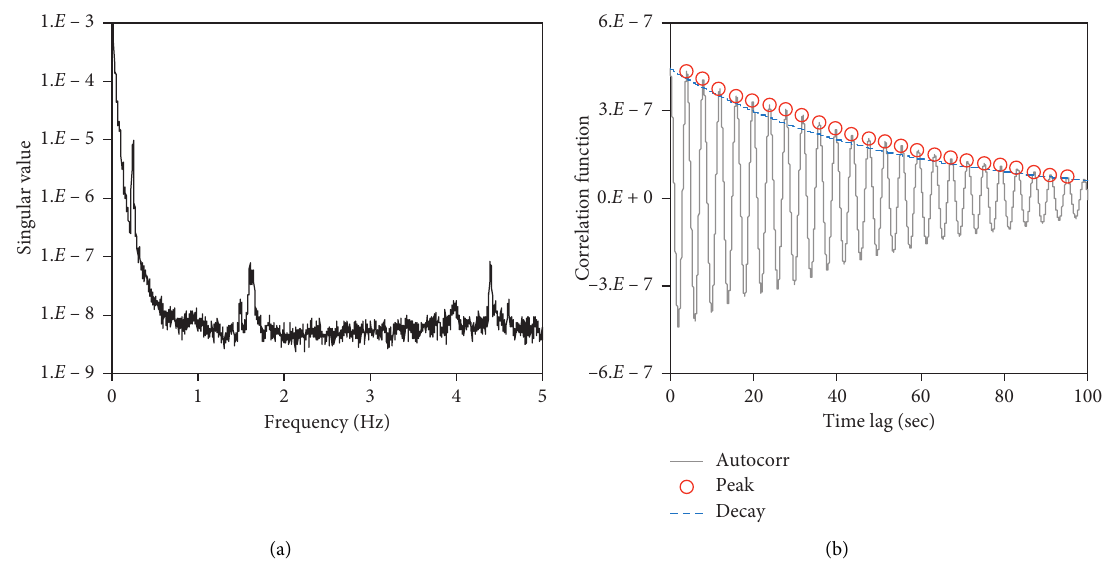
Figure 4: Identification of natural frequency and damping ratio from frequency domain decomposition (FDD) method. (a) Singular value. (b) Correlation function. Table 1: Modal properties of the Busan tower. Natural frequency Mode